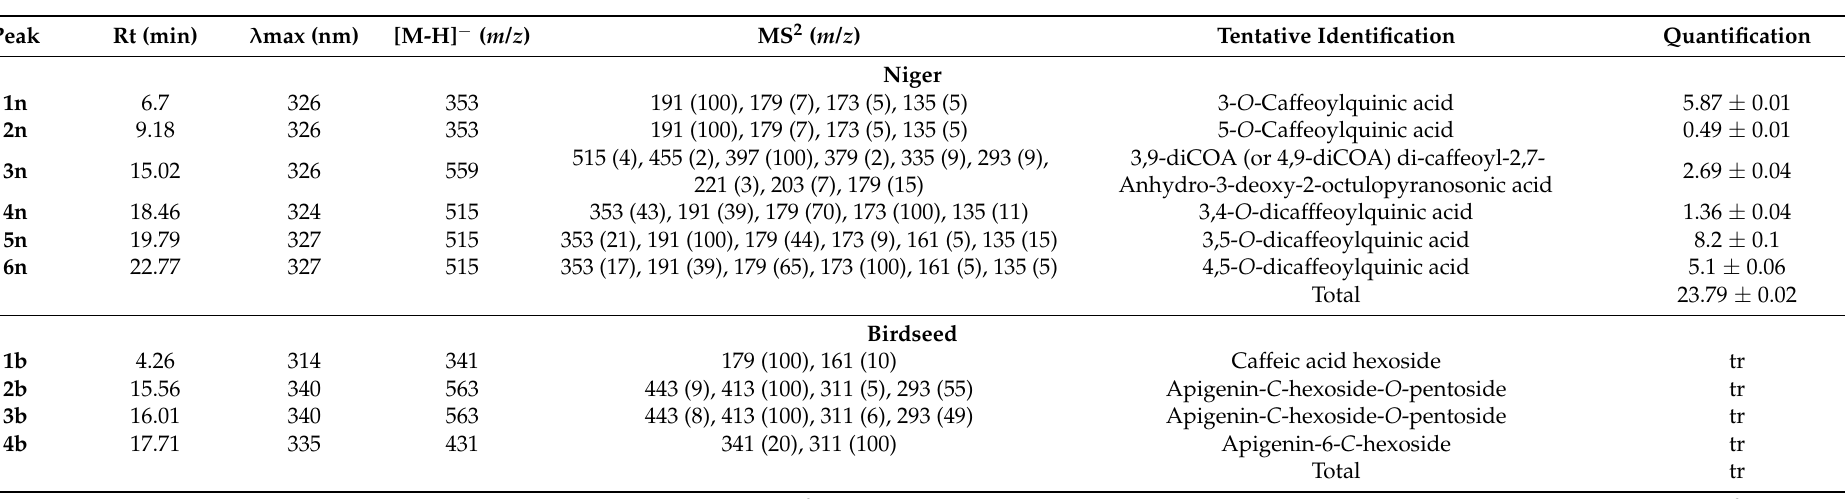
Table 6. Retention time (Rt), wavelengths of the maximum absorption in the visible region ( λ max), mass spectral data, tentative identification and quantification (mg/g of extract) of the phenolic compounds present in the hydroethanolic extracts of niger and birdseed (mean ± SD). Peak Rt (min) Tentative Identification